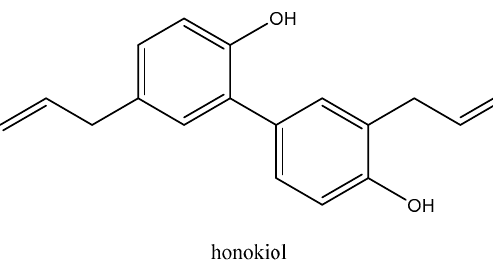
Figure 8. The structure of honokiol (Chemical formula: C 18 H 18 O 2 ; Molecular weight: 266.34). The IDO1 antibody (No: 66528-1-Ig), NF- κ B P65 antibody (No: 14220-1-AP), and the